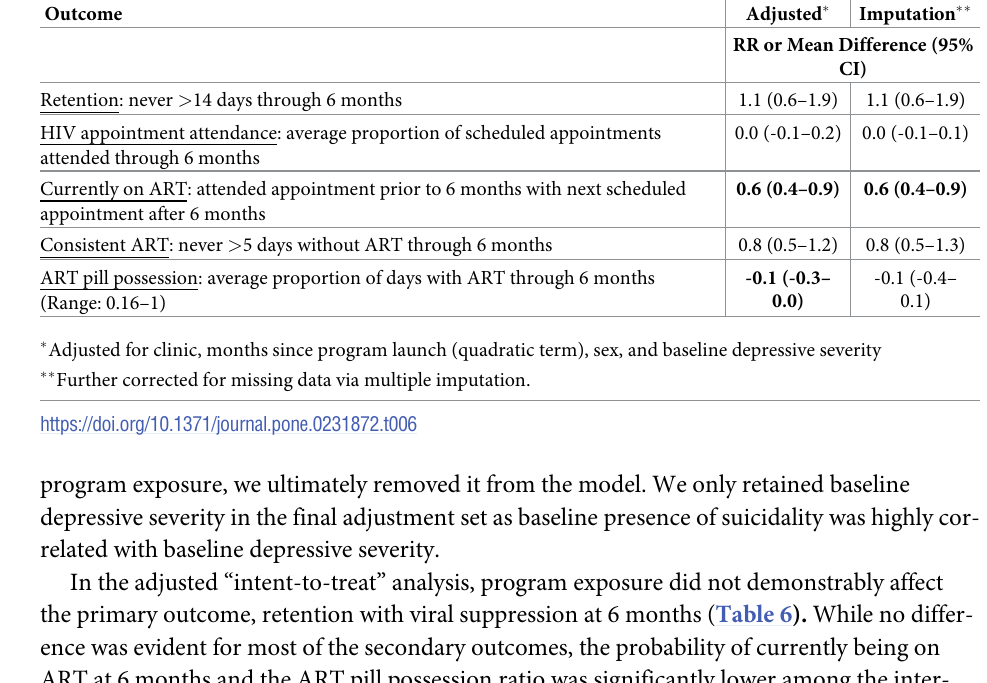
Table 6. Effect of intervention on HIV care and depression